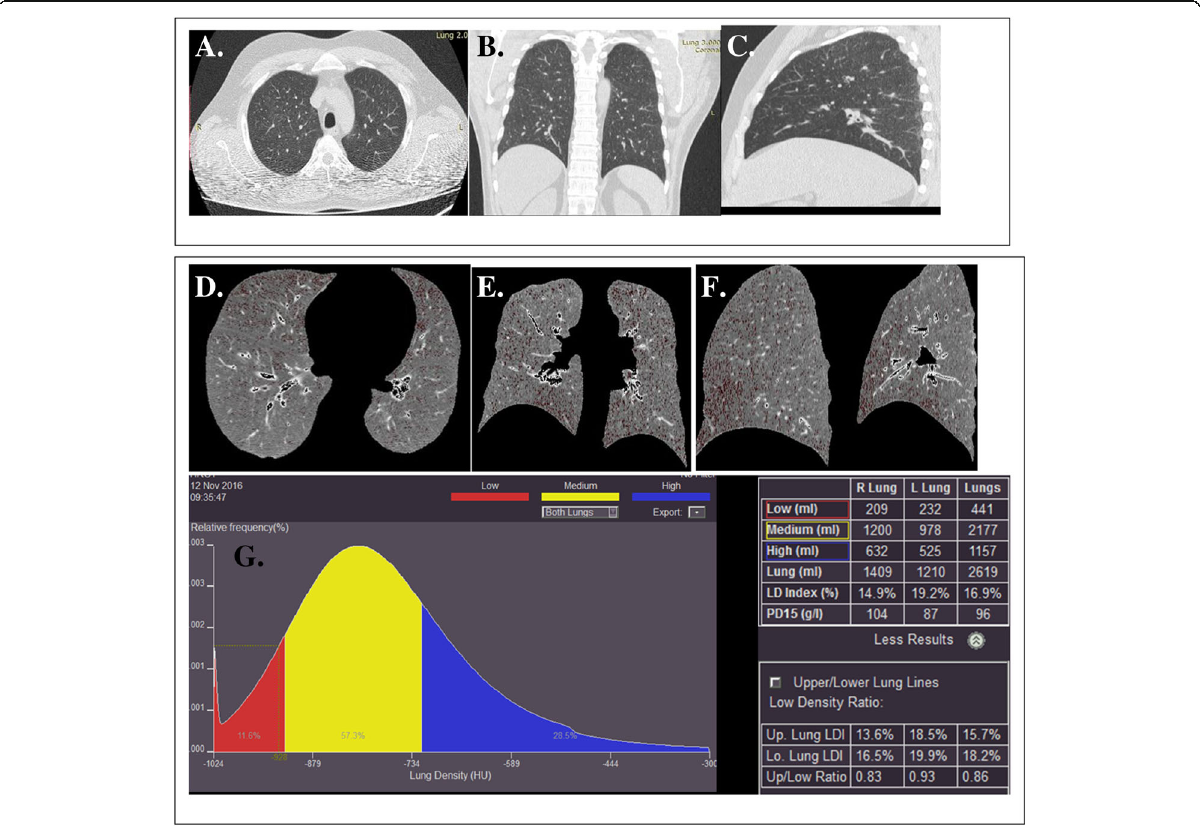
Fig. 2 Male patient, 45 years old, chronic heavy smoker. a – c HRCT images with subtle bilateral diffuse emphysematous changes. d – f After applying density mask, image segmentation. g Lung density histogram. Although pulmonary function tests were normal, there were bilateral emphysematous changes with both lower lobes more emphysematous than both upper lobes as regarding the low-density index that of both lower lobes was 18.2%while that of both upper lobes was 15.7%, and the left lung is more emphysematous than the right lung. Findings revealed more pronounced bilateral diffuse emphysematous changes, more pronounced at the left lower lobe (left lower lobe low-density index 19.9%), and to a lesser degree left upper lobe(left upper lobe low-density index